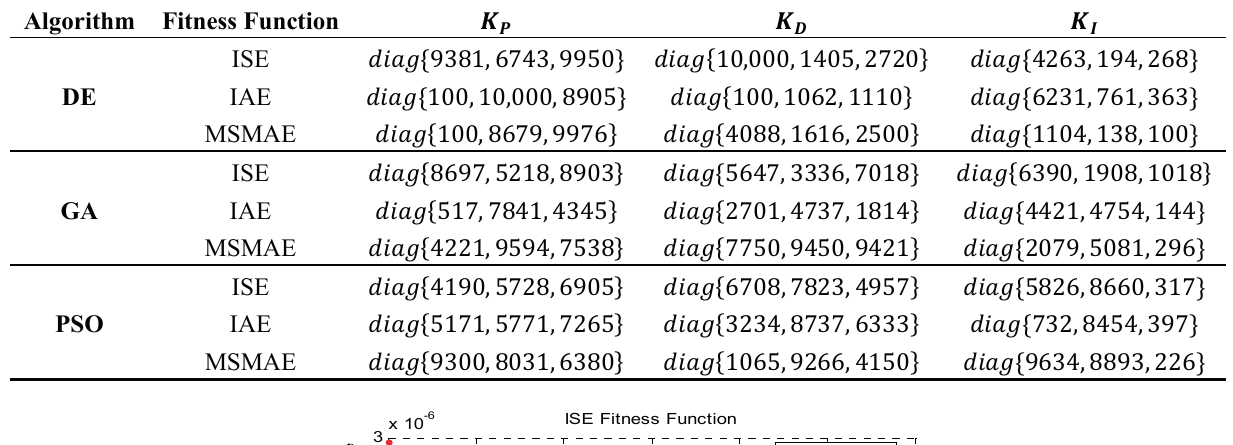
Table 7. Resulting gains for nonlinear contour.